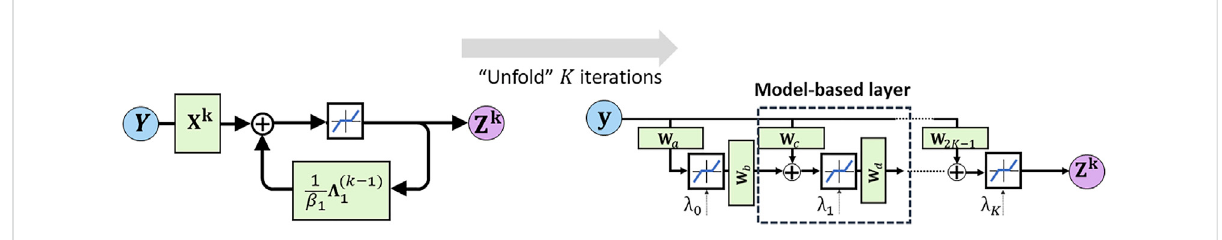
FIGURE 2 Illustrationofdeep unfoldingoftherecurrentupdate algorithmfor Z k .The bluelinewithin theblack box(topcenterintheleftpanel)represents the row-wise shrinkage operator that stimulates sparsity of the ultimate